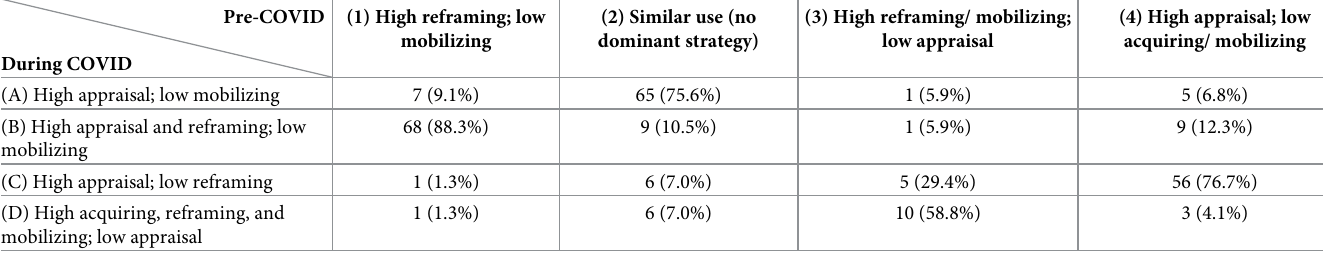
Table 2. Comparisons between clusters before and during the COVID-19